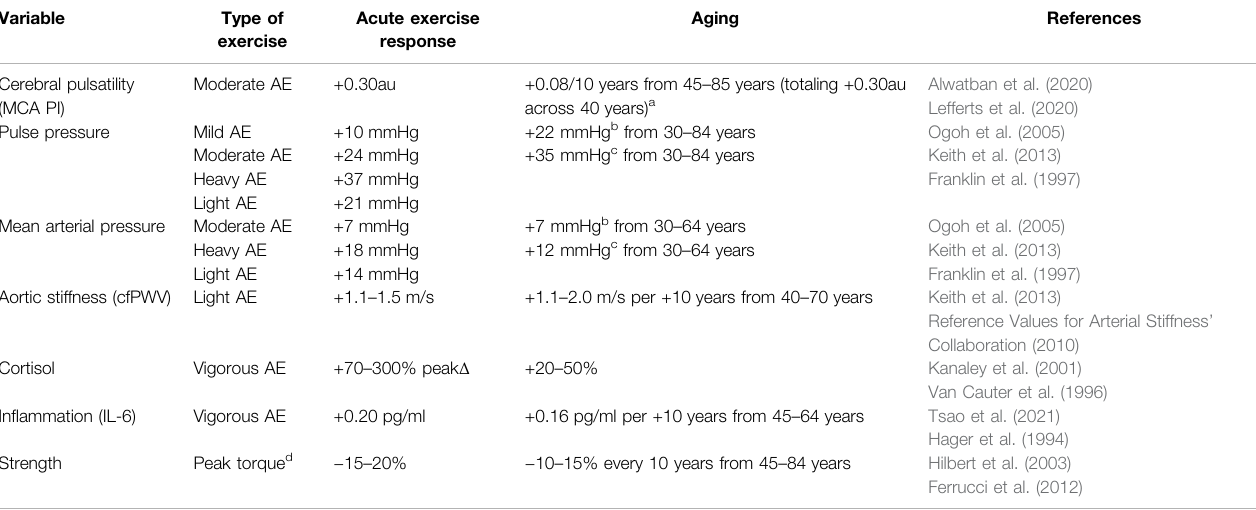
TABLE 1 | Comparison of magnitude of acute exercise response with observed changes in the context of aging from select available literature.